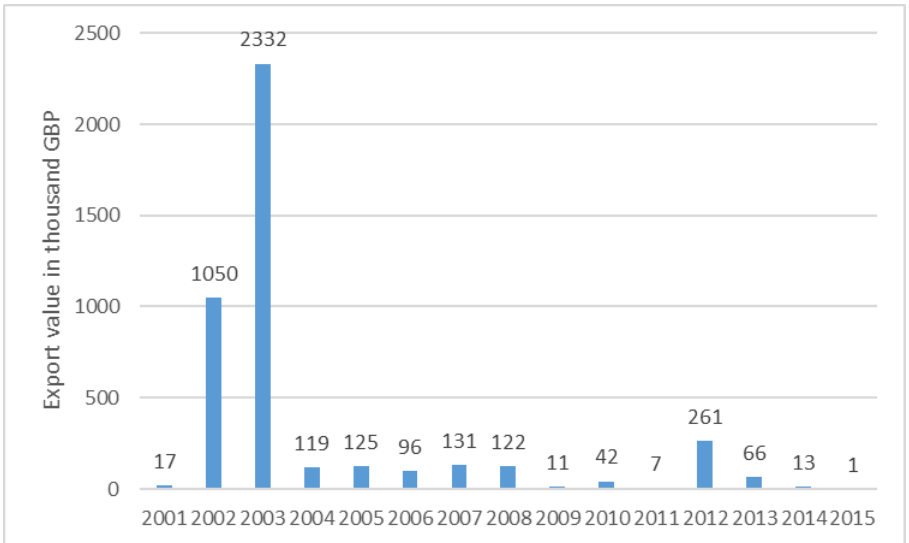
Figure 2. Value of cocoa shells, pod husks, skins, and other cocoa waste exported from the United Kingdom (U.K.) from 2001 to 2015 (in 1000 GBP) [7].